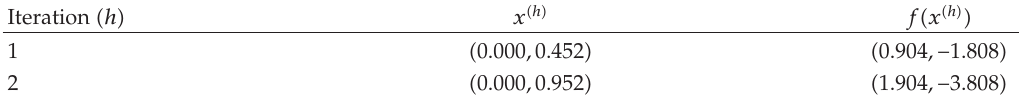
Table 5: The results of classic STEM